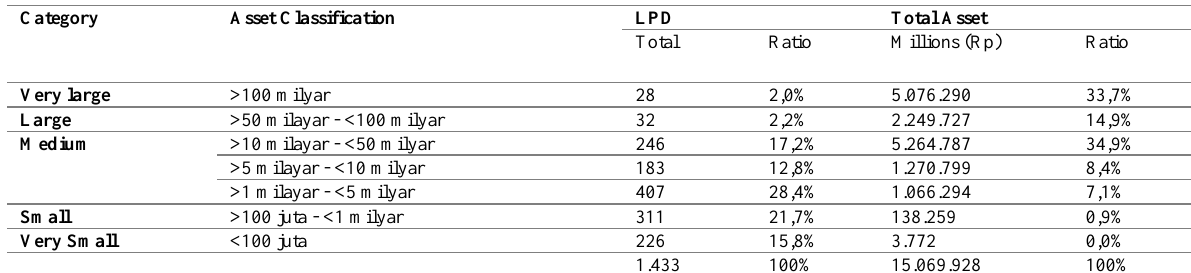
Table 1: LPD in Bali according to total assets